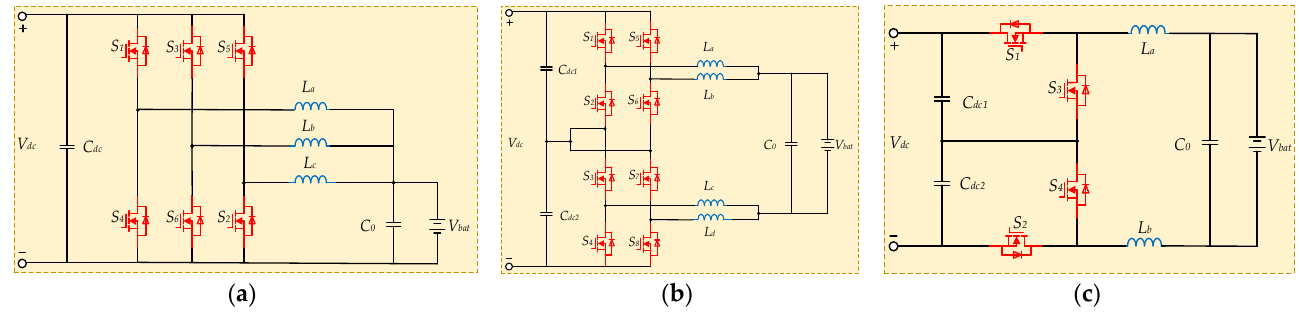
Figure 9. Non-isolated DC/DC converter topology. ( a ) Multi-phase interleaved DC/DC converter. ( b ) Three-level DC/DC converter. ( c ) Three-level asymmetric voltage